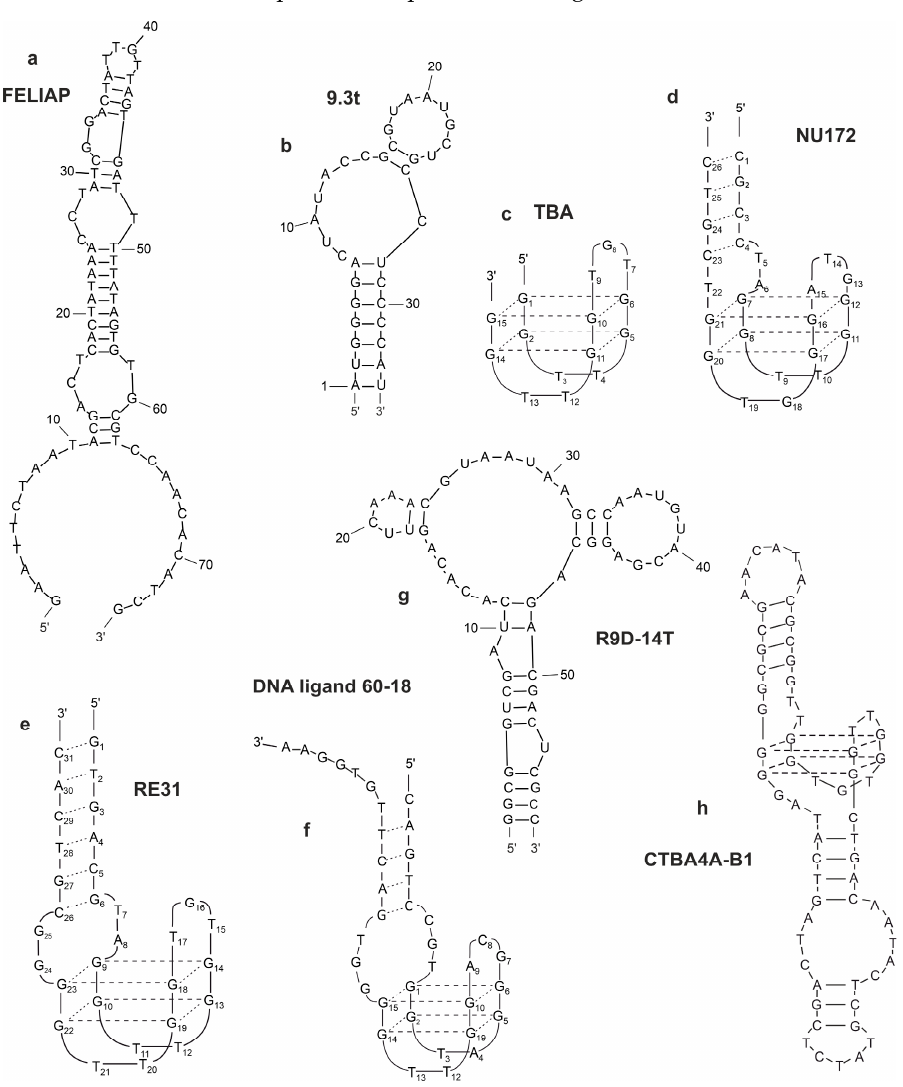
Figure 2. Secondary structures of G-quadruplex aptamers to thrombin: FELIAP ( a ); 9.3 ( b ), TBA ( c ); NU172 ( d ); RE31 ( e ); DNA ligand 60-18 ( f ); R9D-14T ( g ); CTBA4A-B1 ( h ).